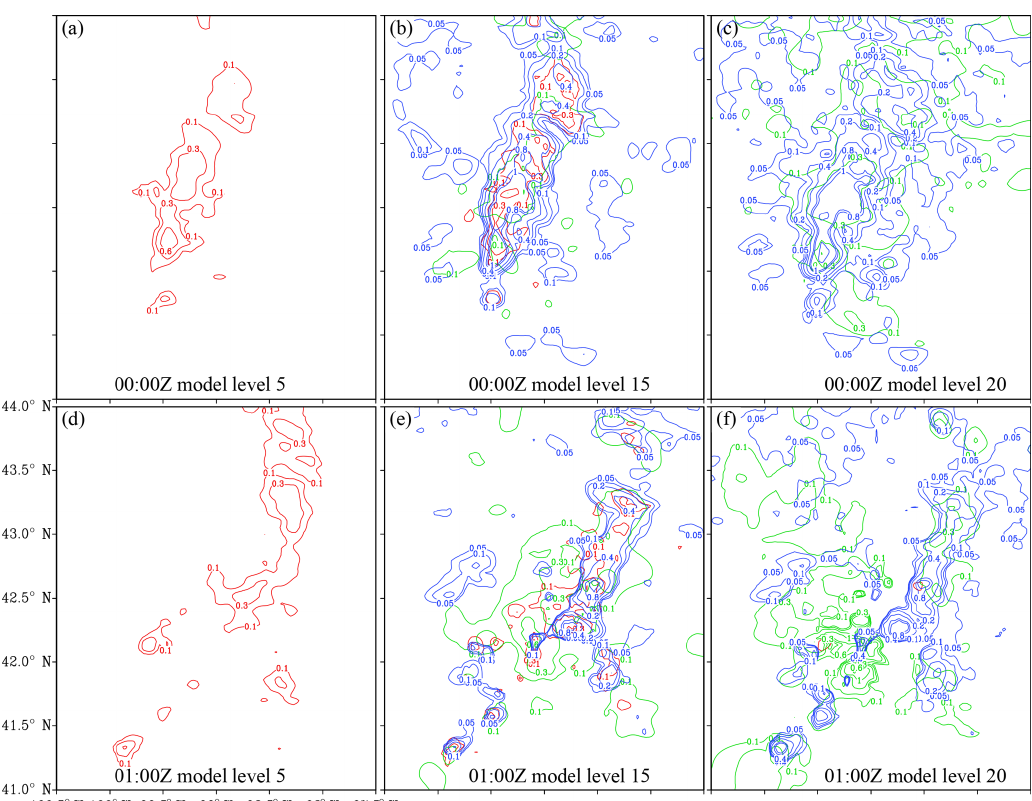
Figure 8. The (a, b, c) 00:00Z and (d, e, f) 01:00Z analyses of q r (red), q s (green), and q g (blue) at model levels 5 (left column), 15 (middle column), and 20 (right column) for outer loop 6 in Exp_ref. Model levels 5, 15, and 20 approximately correspond to 0.7, 4.0, and 8.0kma.g.l.,